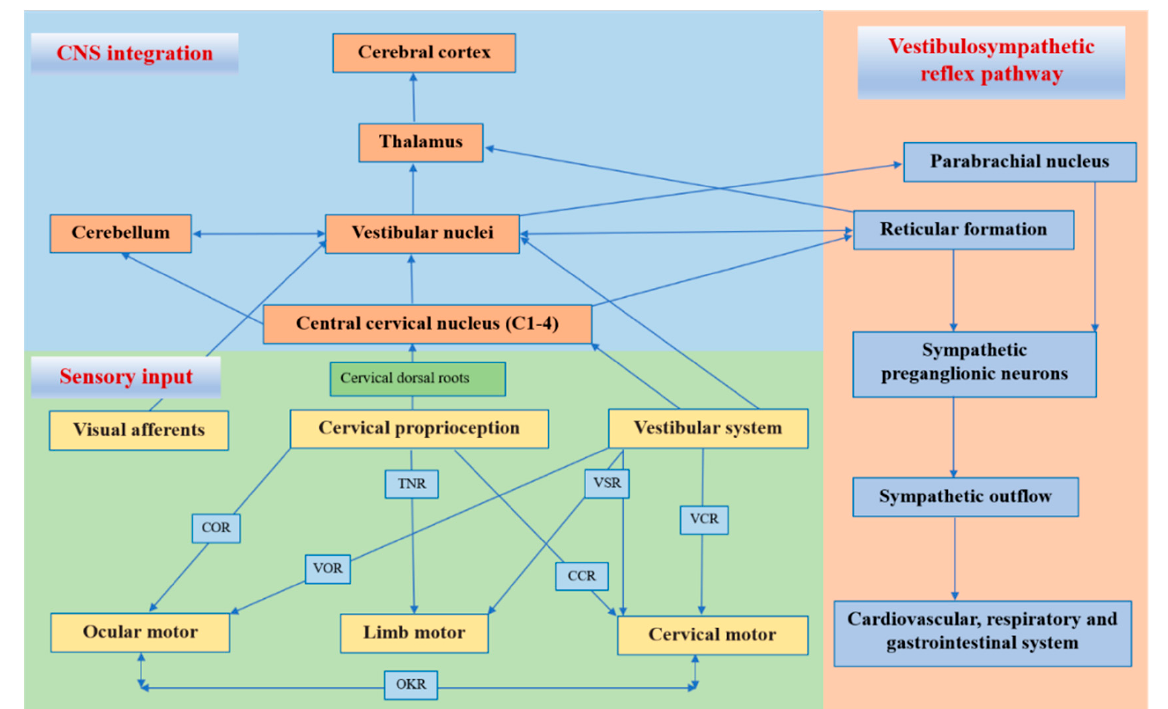
Figure 1. Central and reflex connection for cervical proprioceptive signals. COR = cervico–ocular reflex. VOR = vestibulocular reflex. TNR = tonic neck reflex. VSR = vestibulospinal reflex. CCR = cervico–collic reflex. VCR = vestibulo–collic reflex. OKR = optokinetic reflex.